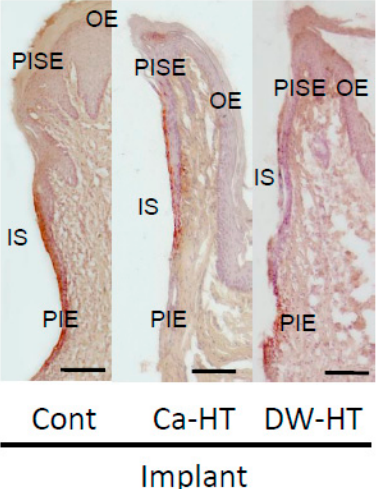
Figure 6. Light micrographs of Ln localization in the oral mucosa around the implants after 16 weeks. The localization of Ln was seen as a band along the implant-PIE interface. Localization of Ln was restricted at the interface between implant and PIE in Ca-HT group. (IS, implant space; OE, oral epithelium; PISE, peri-implant sulcular epithelium; PIE, peri-implant epithelium. Hematoxylin staining. Bar = 100 µ m.